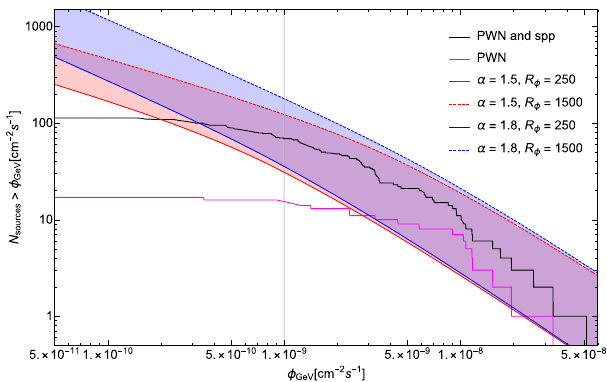
Fig. 4 Pulsar wind nebulae fl ux distribution in the GeV domain. We report with shaded bands the cumulative number N ( Φ GeV ) of sources with fl uxes larger than Φ GeV predicted in our model and in the latitude range ∣ b ∣ ≤ 20.25 ∘ . In particular, the red (blue) band is obtained by assuming α = 1.5 ( α = 1.8) and by considering 250 ≤ R Φ ≤ 1500. The magenta line represents the observed cumulative number of pulsar wind nebulae (PWNe) with fl uxes larger than Φ GeV in the 4FGL-DR2 catalog. The black line also includes SPP sources with potential association with supernova remnant or pulsar wind nebulae. The gray vertical line represents the Fermi-LAT sensitivity threshold for objects in the Galactic (cid:1) (cid:3) F Y ð F E Þ . By using Eq. (3), we see that the emissivity ¼ E Y TeV TeV TeV TeV TeV TeV distribution is not modi fi ed, if the ratio F TeV ; max (cid:1) L TeV ; max = E TeV is kept constant.